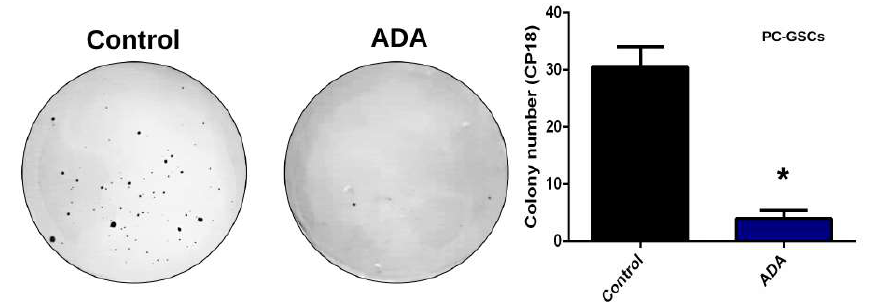
and 100 nM Vincristine. n = 3, * p < 0.05; ** p < 0.01.